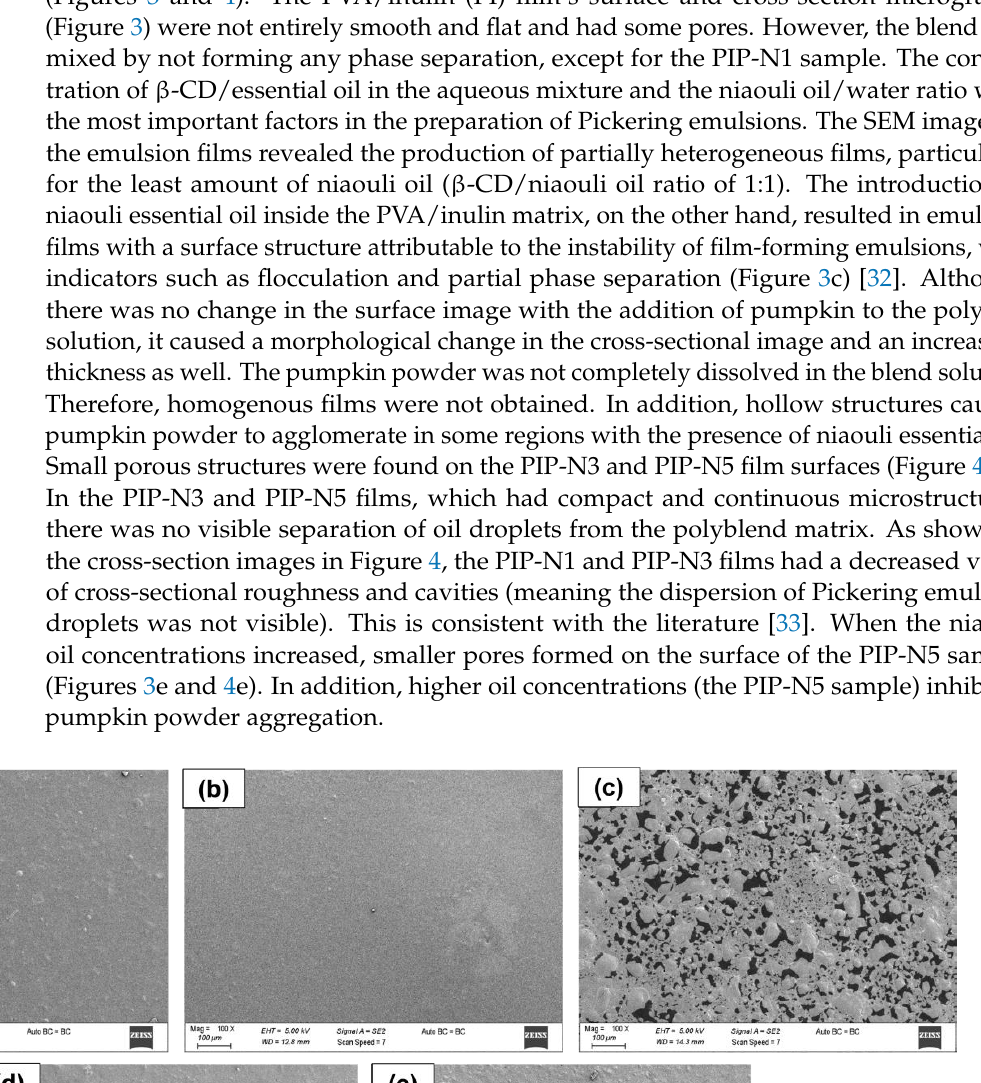
Figure 4. Cross-sectional SEM images of the ( a ) PI film, ( b ) PIP film, ( c ) PIP-N1 Pickering film, ( d ) PIP-N3 Pickering film, and ( e ) PIP-N5 Pickering film. 3.2. FT-IR Spectroscopy The functional groups of the polymer films and active compounds (pumpkin powder and niaouli essential oil) were verified using FTIR spectrophotometry, and Figure 5 shows the FTIR spectra of all the film samples. The spectra of the neat film showed the characteristic peaks of PVA and inulin. As seen in the PI spectrum, the peak at 3293 cm −1 corresponded to – OH stretching, whereas